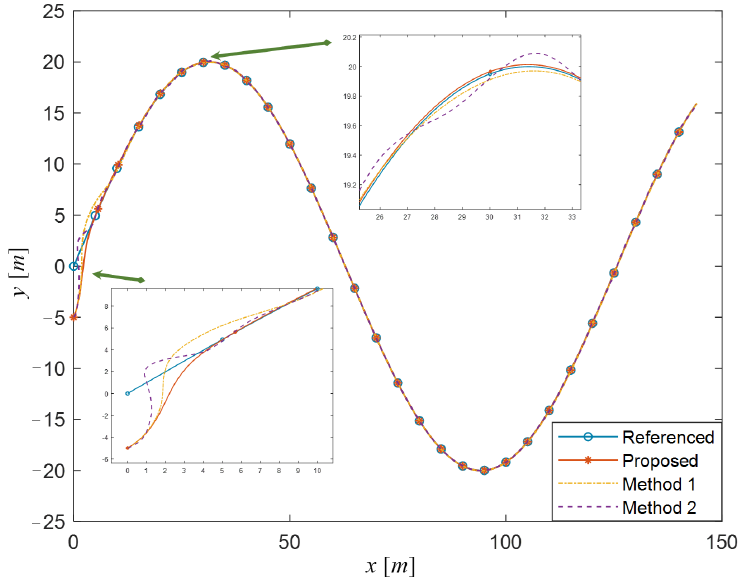
Figure 5. The different methods under the influence of